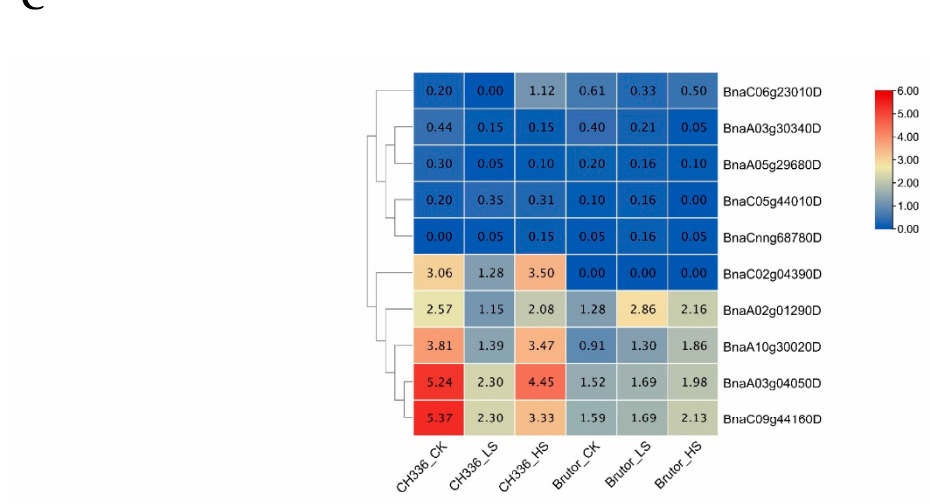
Figure 4. FPKM( − normalized heatmaps of some candidate di ff erentially expressed genes (DEGs) potentially involved in stimulating the seedling growth under moderate salinity stress in Brassica napus . ( A ). Six DEGs commonly shared between LS/CK and LS/HS and with similar expression patterns in two oilseed rape varieties (CH336 and Brutor). ( B ). 13 B. napus DELLA family genes. ( C ). 10 B. napus MYB46 genes.